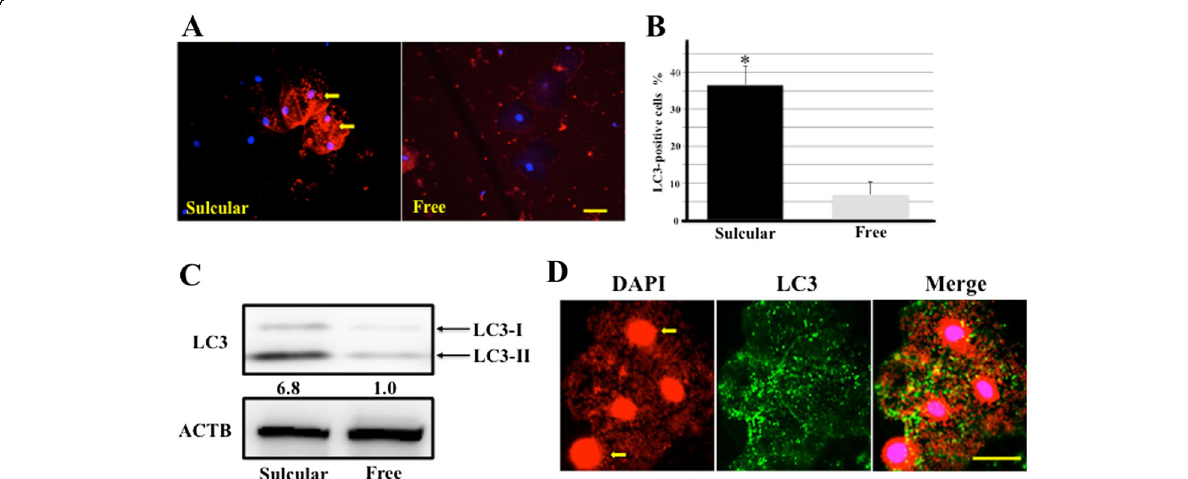
Fig. 4 LC3 expression in exfoliative sulcular keratinocytes. a Immunofluorescence of LC3 expression (red) in exfoliative cells from gingival sulcus (Sulcular) and free (Free) gingiva. The nucleus was stained with Hoechst 33342 (blue). Arrows, LC3-positive autophagosomes. Bar=20 μ m. b Quantitative analysis of percentage of LC3-positive cells in exfoliative cells from gingival sulcus and free gingiva. Mean number of the percentage of LC3-positive cells ± SD from five independent studies. *Significantly different at P <0.05 compared with exfoliative cells from the free gingiva. c Western blotting analysis of LC3 expression in exfoliative cells from gingival sulcus and free gingiva. β -actin (ACTB) was used as a loading control. Band densities were presened as LC3 expression fold-increases (normalized to ACTB) and compared with the results for exfoliative cells from free gingiva. Quantification results are shown below the corresponding blots. All experiments were performed in quadruplicate. d Fluorescent localization of DAPI-positive bacteria (red) and LC3-positive autophagosomes (green) in exfoliative sulcular cells. Arrows, DAPI-positive nuclei (red) in sulcular keratinocytes. Bar = 20 μ